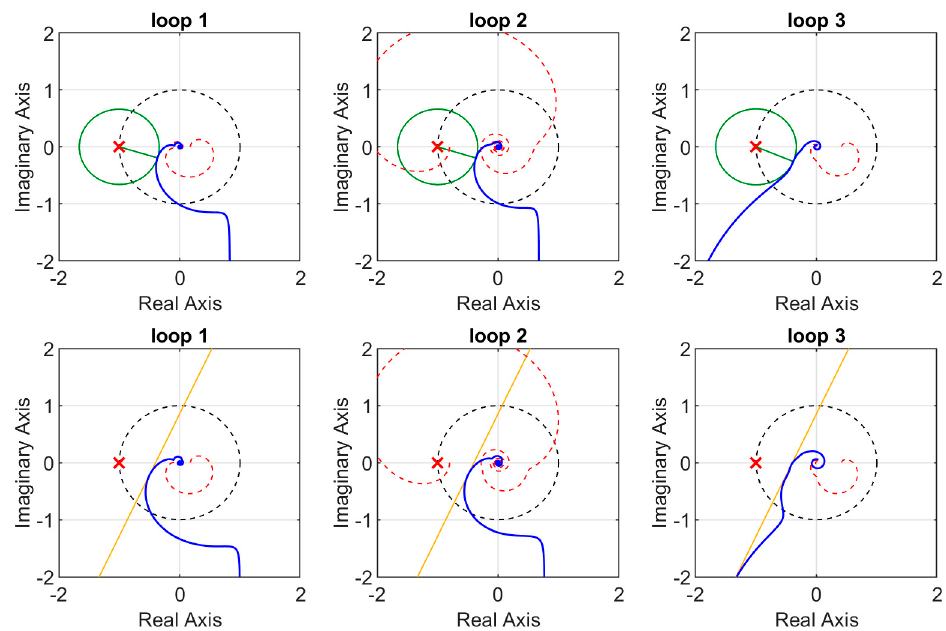
Figure 13. Nyquist diagrams obtained with the proposed controllers in example 2 (first row for proposal 1 and second row for proposal 2). The EOP is in the dashed red line and the loop (EOP with PI controller) in the solid blue line.